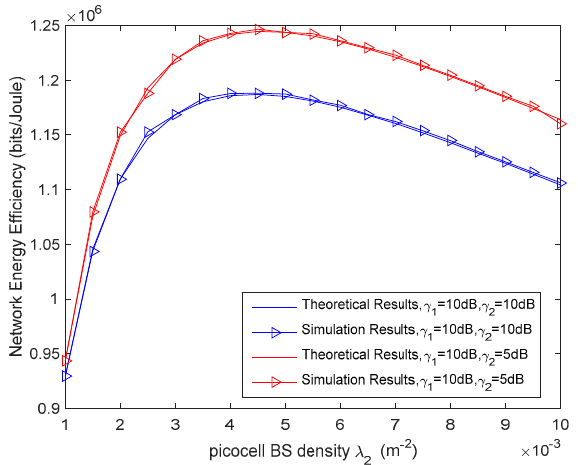
Figure 2. Network energy efficiency (EE) versus picocell base station (BS) density.